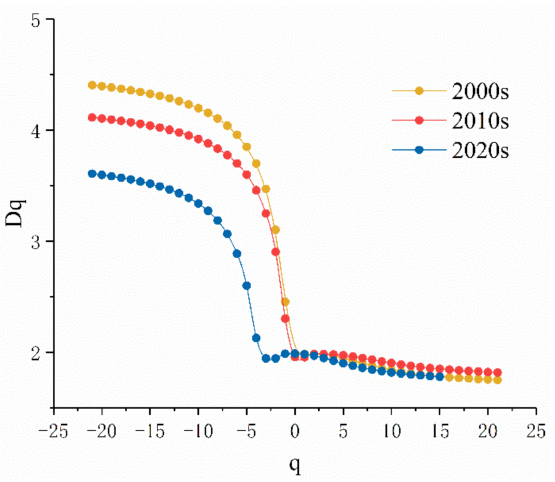
Figure 7. The relationship between generalized multifractal dimension D q and order moment q in the 2000s, 2010s, and